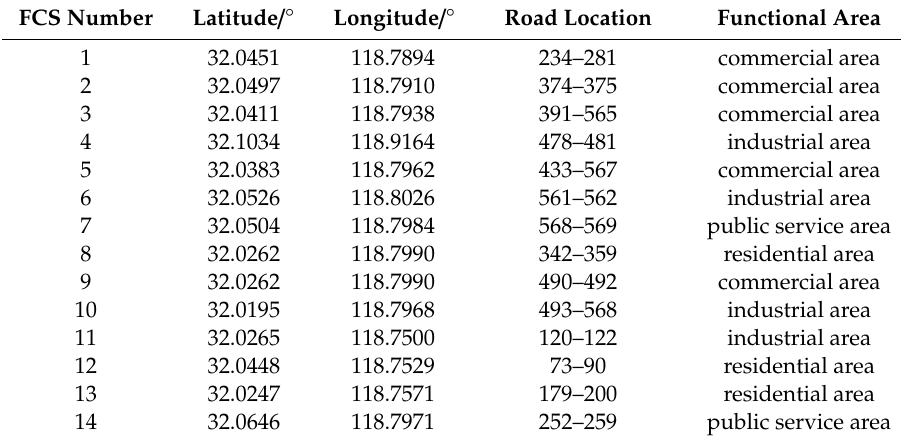
Table A3. Geographic position information of fast-charging stations.